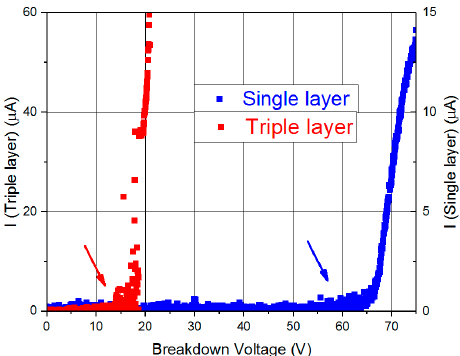
Figure 11. Breakdown current–voltage curves for the single dielectric layer (red) and three-layered (blue) capacitors. Representing the intensity ( I ) recorded by the ammeter (Figure 5) as a function of the applied voltage, it is possible to find the breakdown values, which are indicated by an arrow.